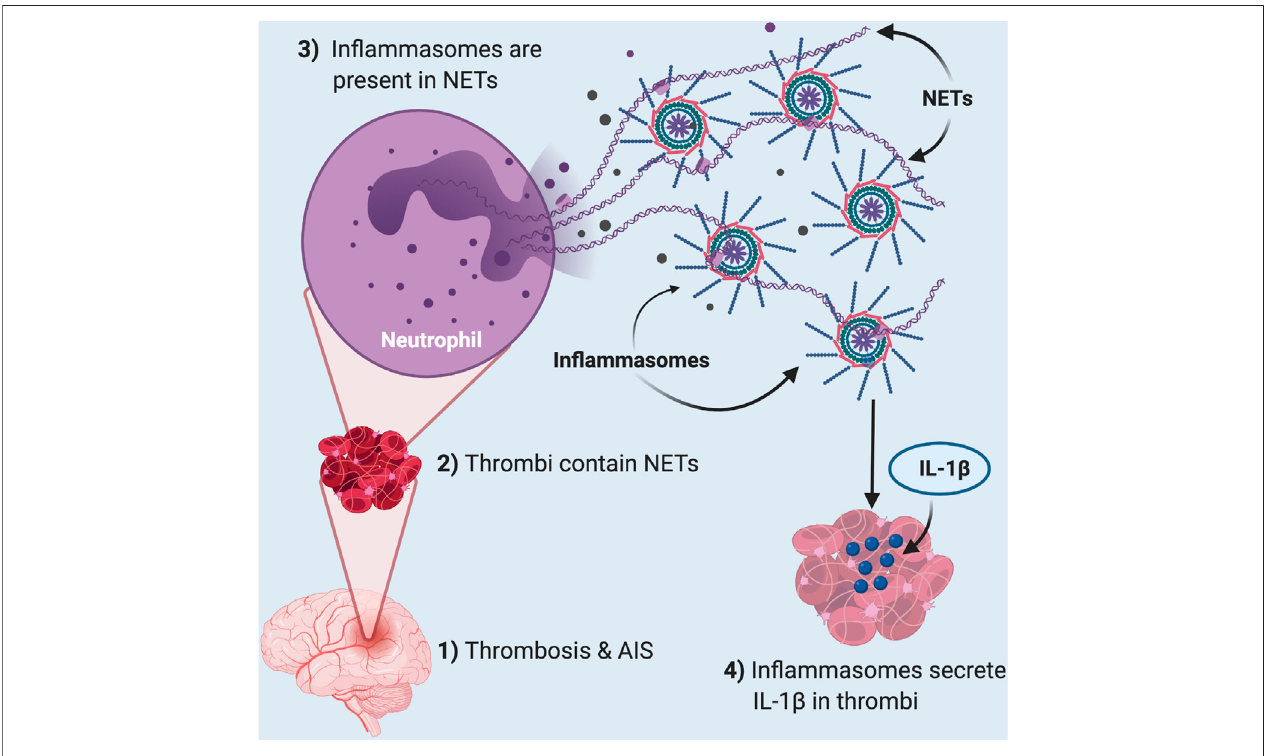
FIGURE 6 | Thrombosis in acute ischemic stroke induces in fl ammasome activation in NETs present in clots. In AIS (1), thrombi (2) contain neutrophil extracellular traps (NETs) that contain in fl ammasomes (3). These in fl ammasomes are responsible for the released IL-1 β in the thrombi of these patients (4).